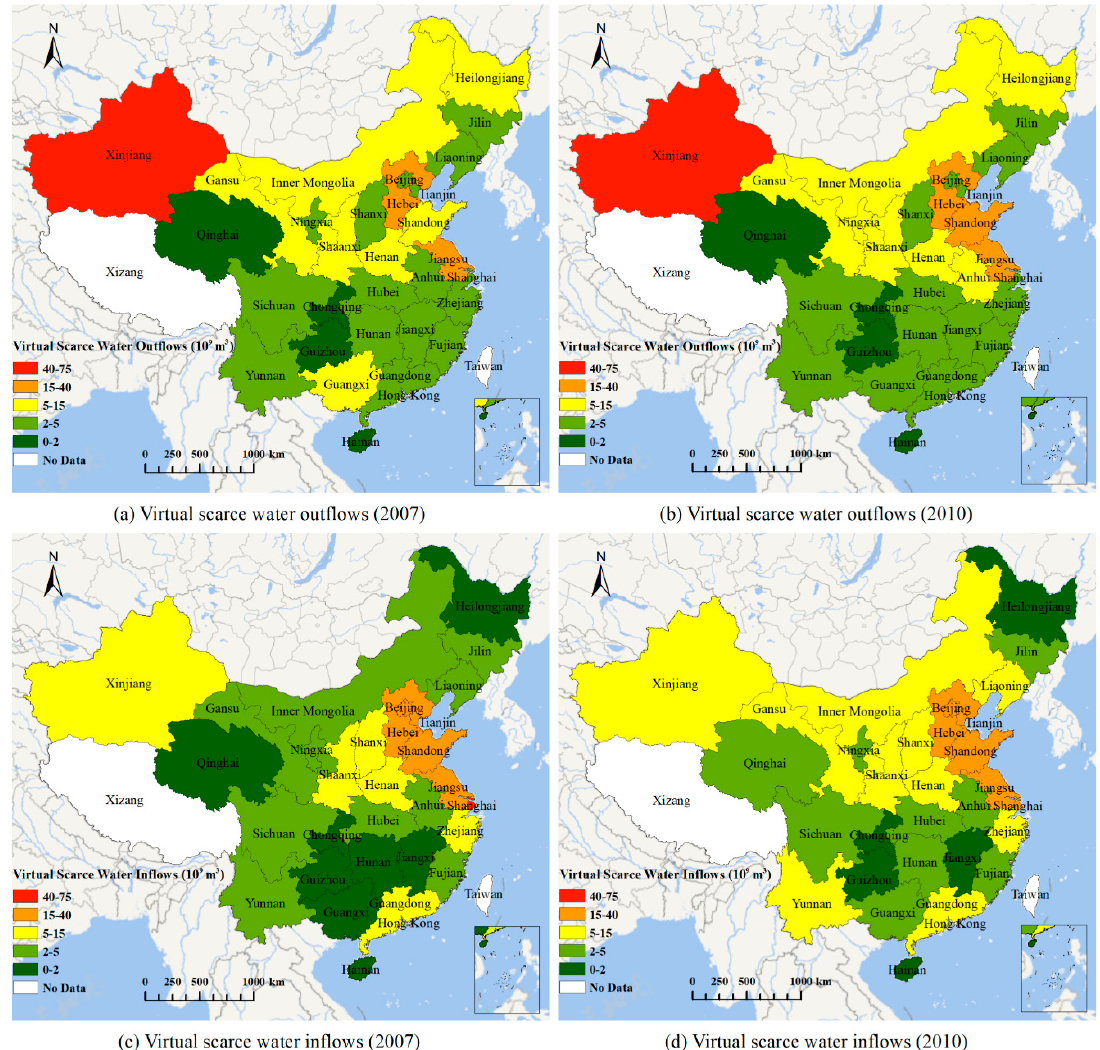
Figure 6. The amounts of VSW outflows/inflows for China’s 30 provinces.